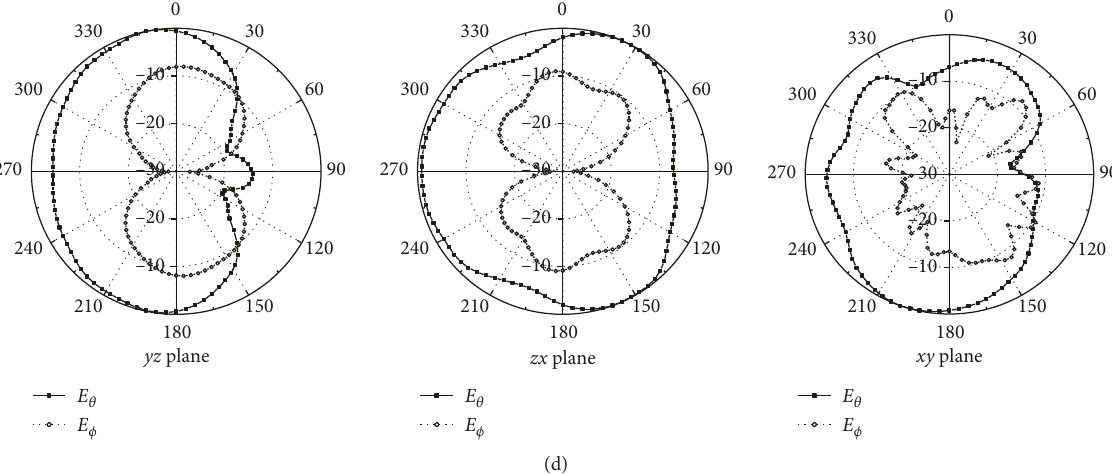
Figure 8: Measured radiation patterns of the proposed antenna at (a) 750MHz, (b) 1800MHz, (c) 2500MHz, and (d) 3450MHz.